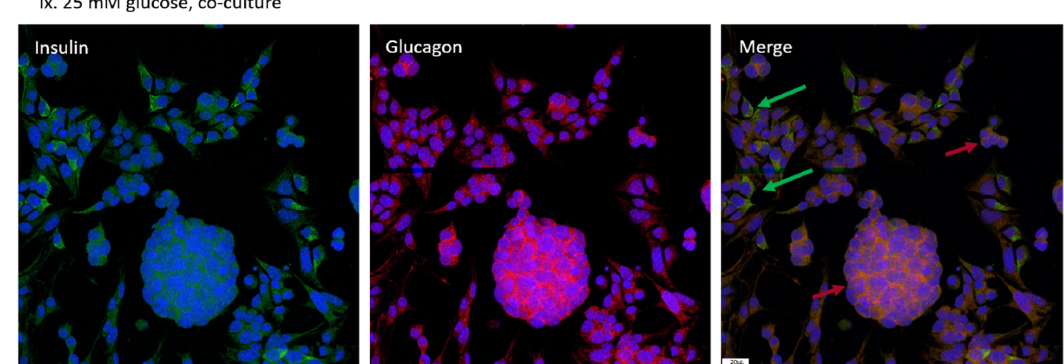
Figure 3. Representative immunocytochemistry microscopic appearance of mono-cultured MIN-6 cells ( i – iii ), mono-cul- tured α -TC1-6 cells ( iv – vi ), and co-cultured cells ( vii – ix ). Cells were visualized by laser scanning confocal microscopy after 72 h incubation in 5.5, 11.1, or 25 mM glucose. Cells were stained with both antibodies against insulin (green) and glucagon (Pink). In co-cultured conditions ( vii – ix ), MIN-6 cells were indicated by green arrows and α -TC1-6 cells were indicated by pink arrows. Scale bar are representative = 20 μ m. Images of 1 representative view for each condition are shown (n = 5).